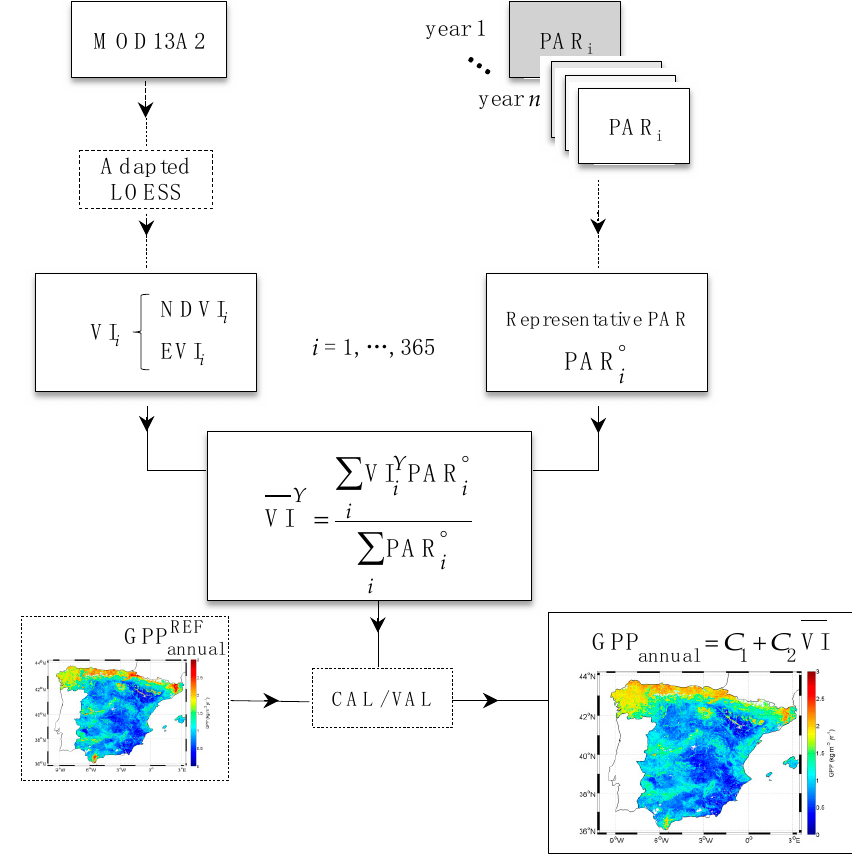
Figure 2. Flowchart of GPP annual estimation using the PAR-weighted VI (being VI = NDVI, EVI).